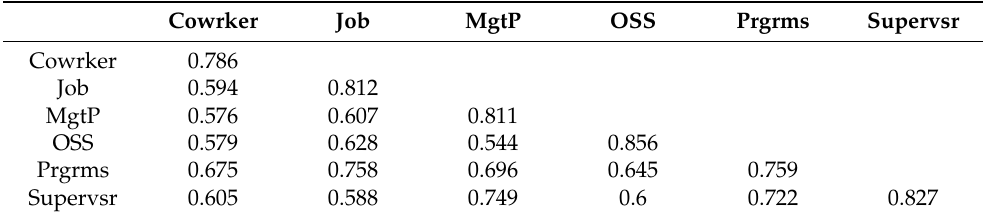
Table 4. Discriminant validity